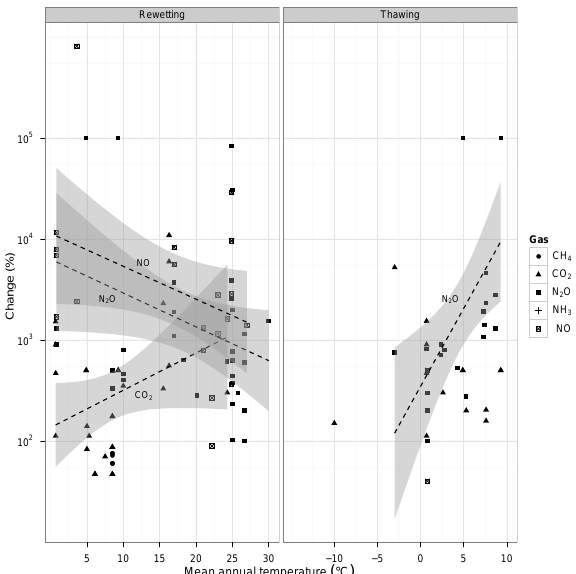
Fig. 5. Pre-change flux (normalized to common units of mggasm − 2 h − 1 for field measurements, and mggaskg − 1 h − 1 for lab incubations) versus flux change (i.e. peak flux as a percentage of pre-event flux), by gas and rewetting or thawing. Only statistically significant relationships (for CO 2 , N 2 O and NO on left) are shown.